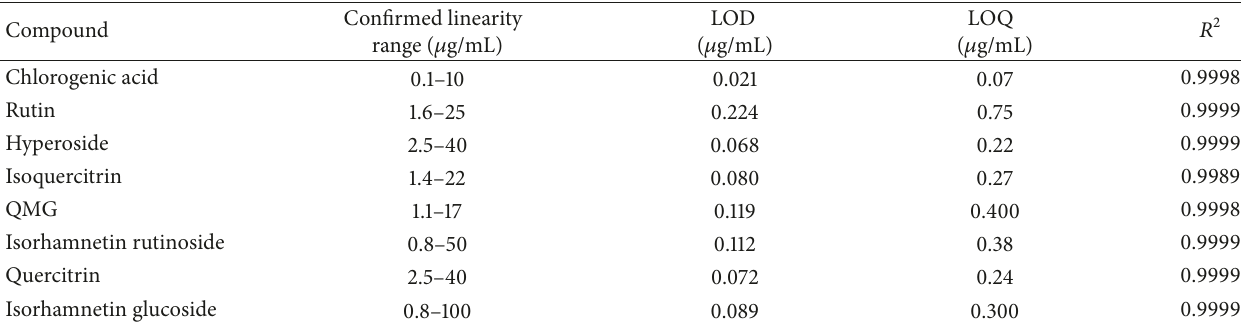
Table 1: Characteristics of the quantitative evaluation of phenolic compounds.